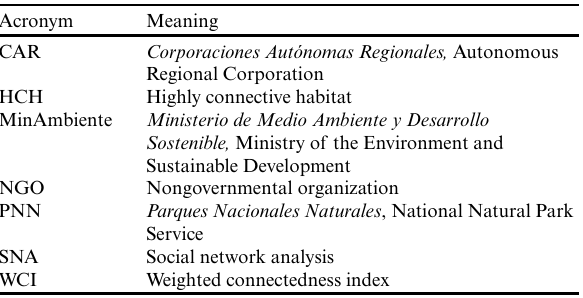
Table 1 . Glossary of